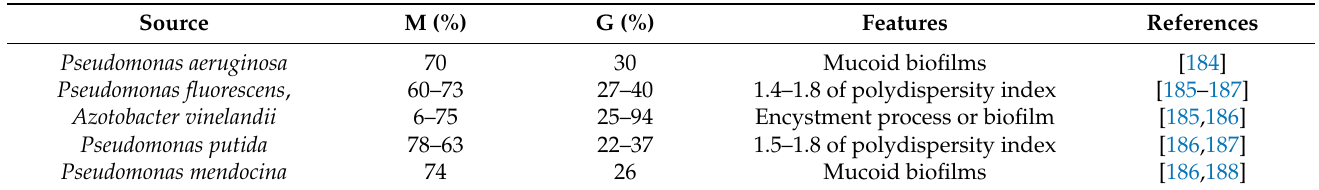
Table 4. Main alginate types produced from different bacterial cultures, M/G ratios, and characteris- tics of